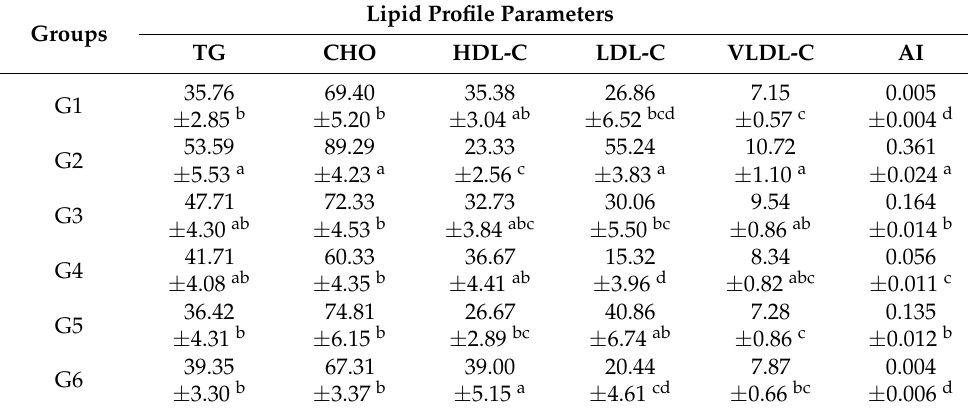
Table 5. Effect of FS and FSS extracts on lipid profile and atherogenic index in CCl 4 -induced nephrotoxicity and oxidative stress in rats (mean ± SE), n = 8. Lipid Profile Groups